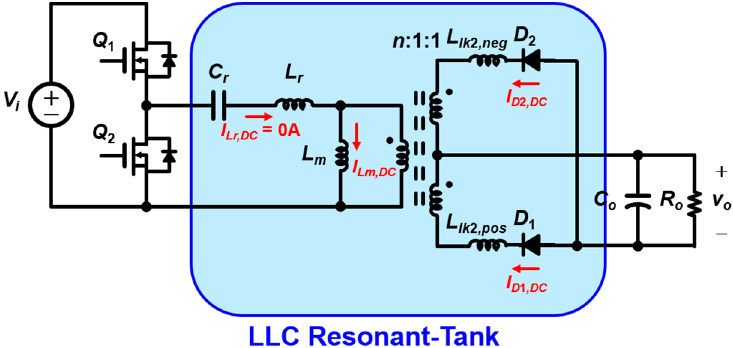
Figure 3. The DC current path in the LLC resonant tank when the leakage inductances at the secondary side are mismatched ( L lk 2, pos < L lk 2, neg ).